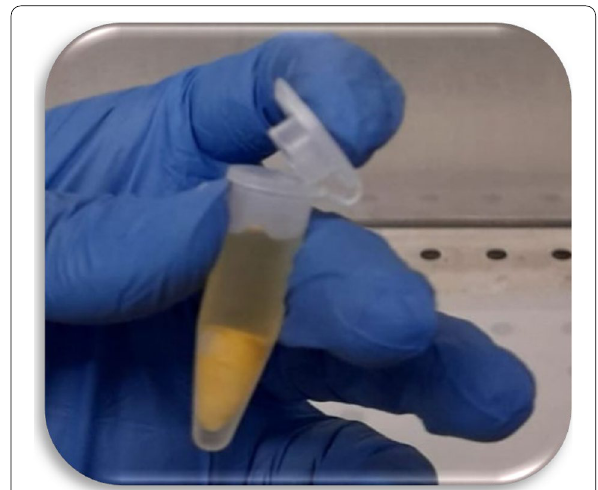
Fig. 3 Infection of teeth with E. faecalis